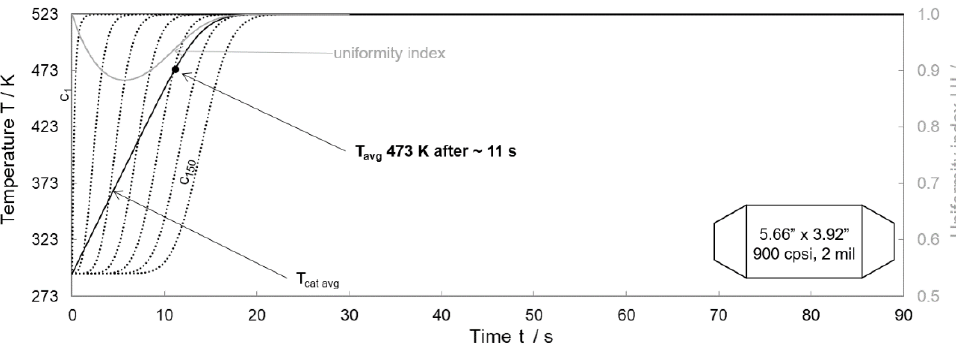
Figure A5. Heat-up of 750 cpsi, 2 mil with reduced length at steady state heat-up.